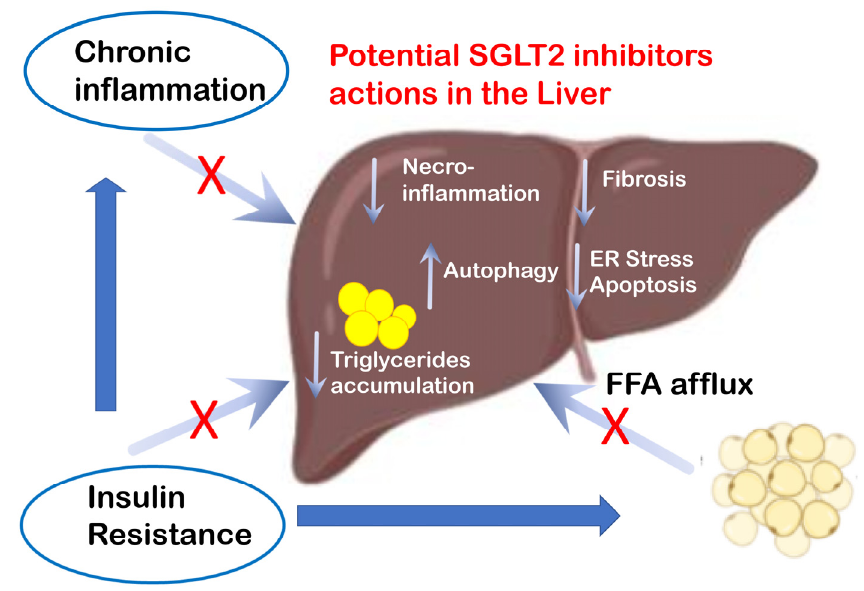
Figure 1. Potential actions of SGLT2-i on several functions related to NAFLD